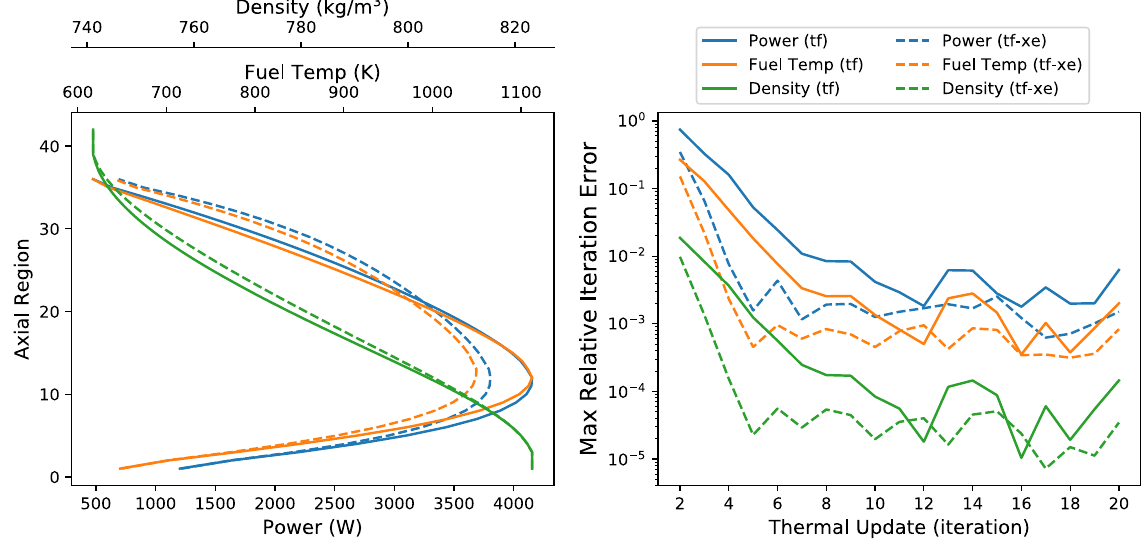
Figure 1: Reference solutions for TF and TF-XE